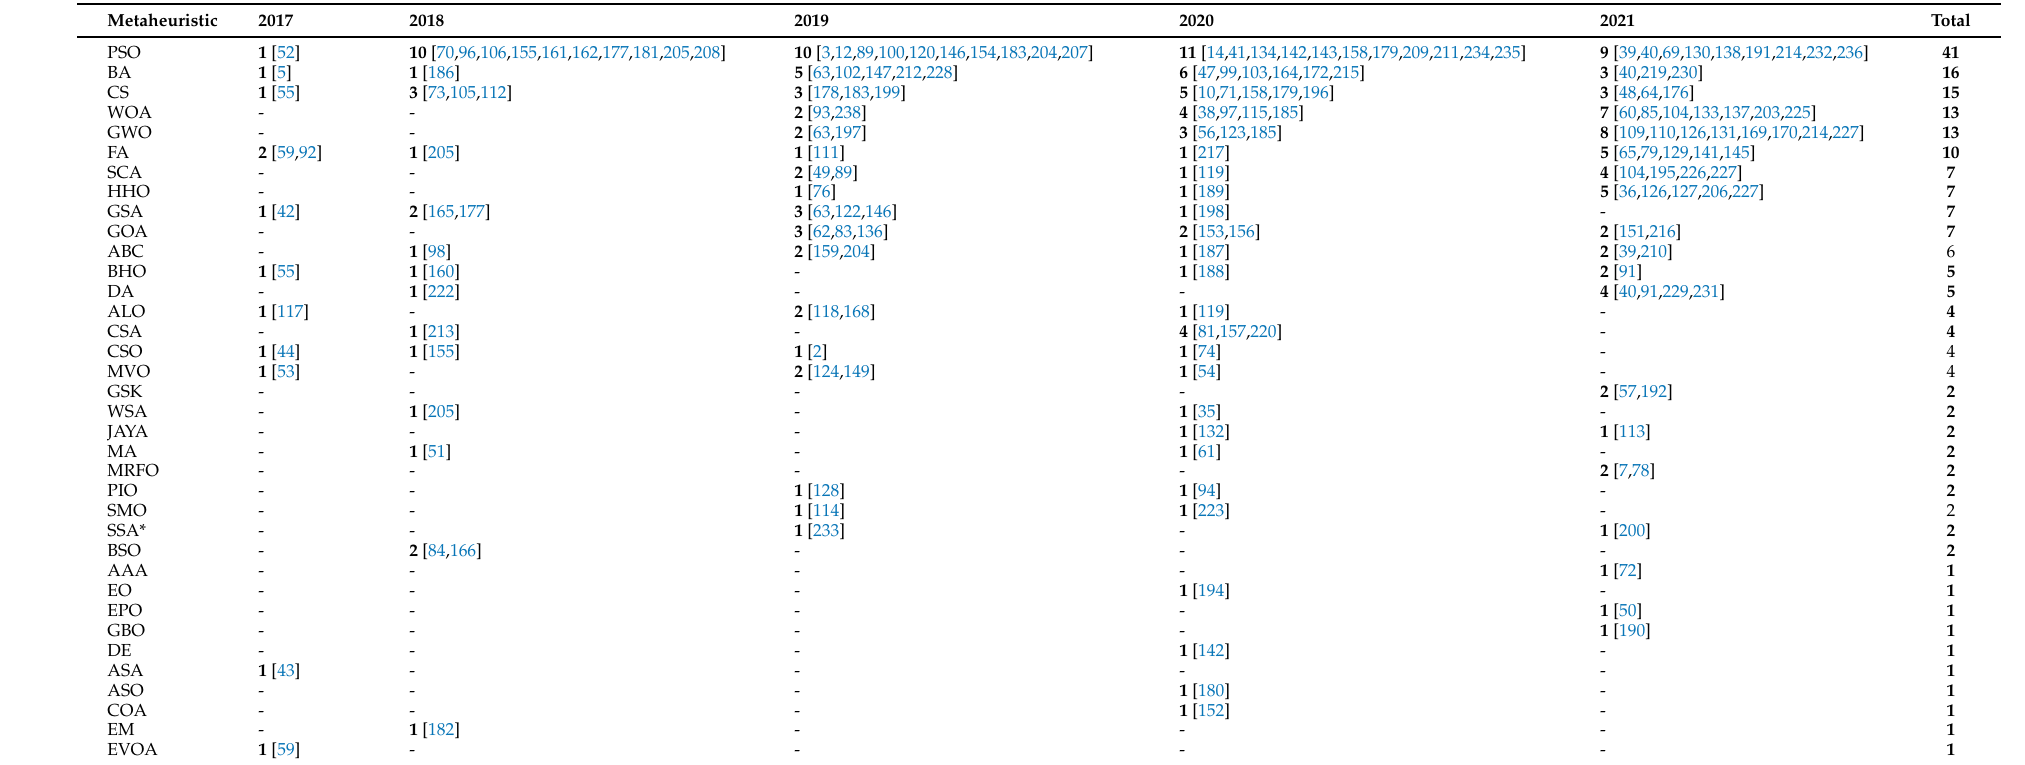
Table 6. Metaheuristic per